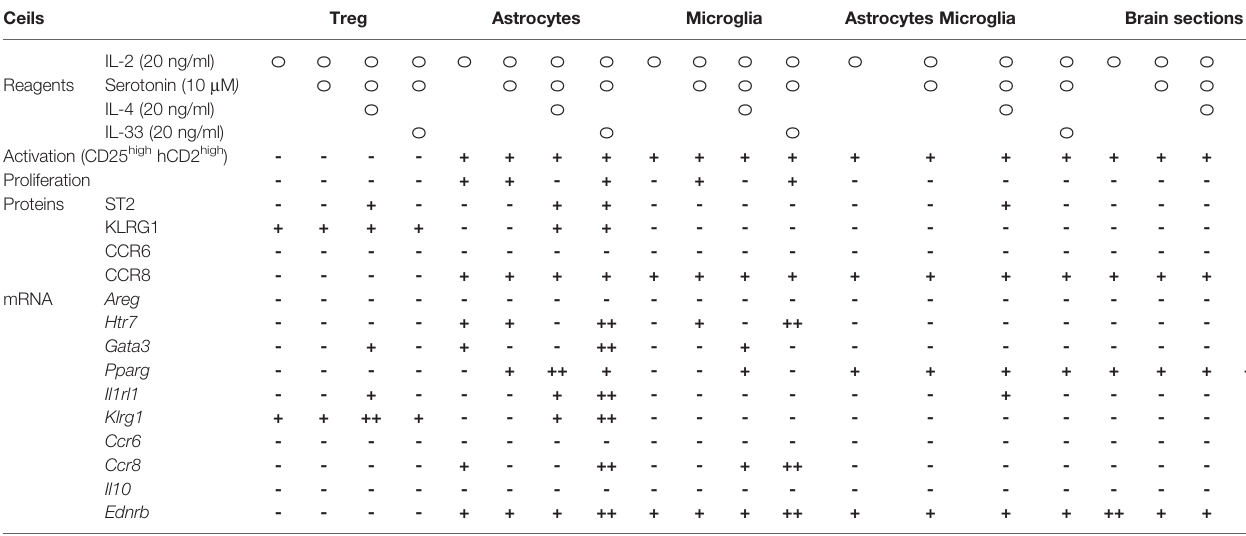
TABLE 3 | Expression of brain Treg markers by the indicated combination of cytokines. Ceils Treg Astrocytes